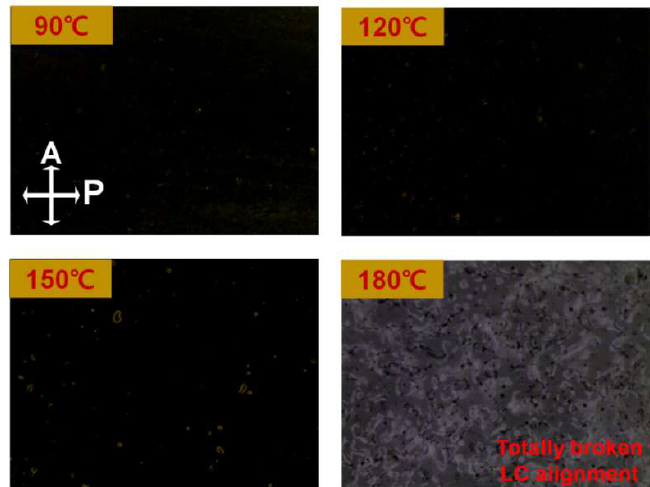
Figure 7. Thermal stability tests of the LCs in the AP-LC cell made from brush-coated LaYSrO layers cured at 270 °C. Annealing was performed from 90 °C to 180 °C in steps of 30 °C for 10 min at each temperature, and the results were measured by POM.